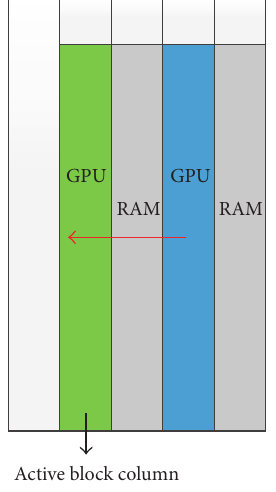
Figure 8: Data transfer of the GPU-CPU out-of-core scheme.